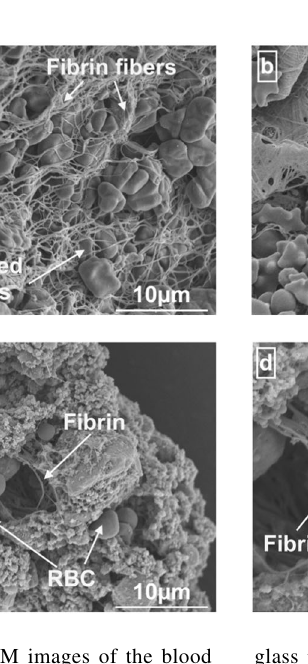
Fig. 3 Blood clot evaluation. It shows SEM images of the blood clots: a clot without a sample : a physiological blood clot shows RBCs entrapped in the fi brin meshwork; b clot with Arista TM : the Arista TM particles are fused to form a fl at sheet below which a blood clot (RBCs entangled in the fi brin meshwork) is seen, c clot with Ta-MBG : a blood clot is seen around Ta-MBG particles and